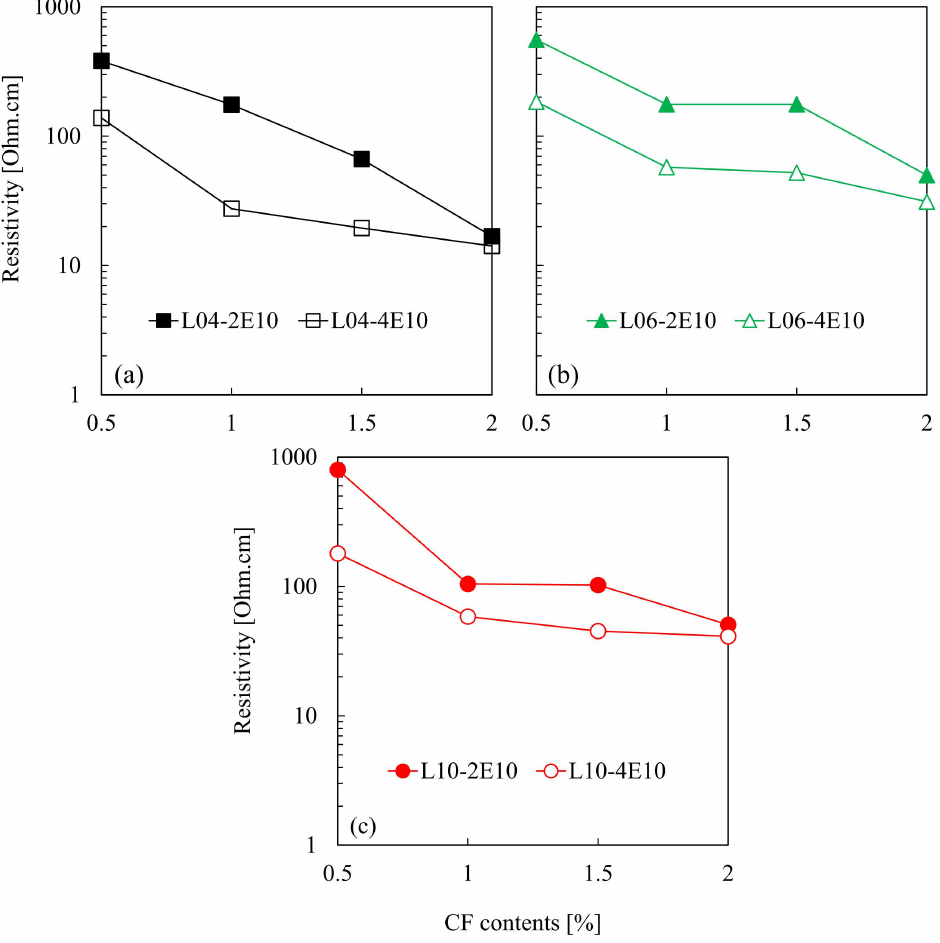
Figure 8. Comparison of resistivity of cement composites as a function of the CF content measured via two- and four-probe configurations corresponding to 10 mm electrode spacing (2E10 and 4E10) and CF lengths of ( a ) 4 mm (L04), ( b ) 6 mm (L06), and ( c ) 10 mm